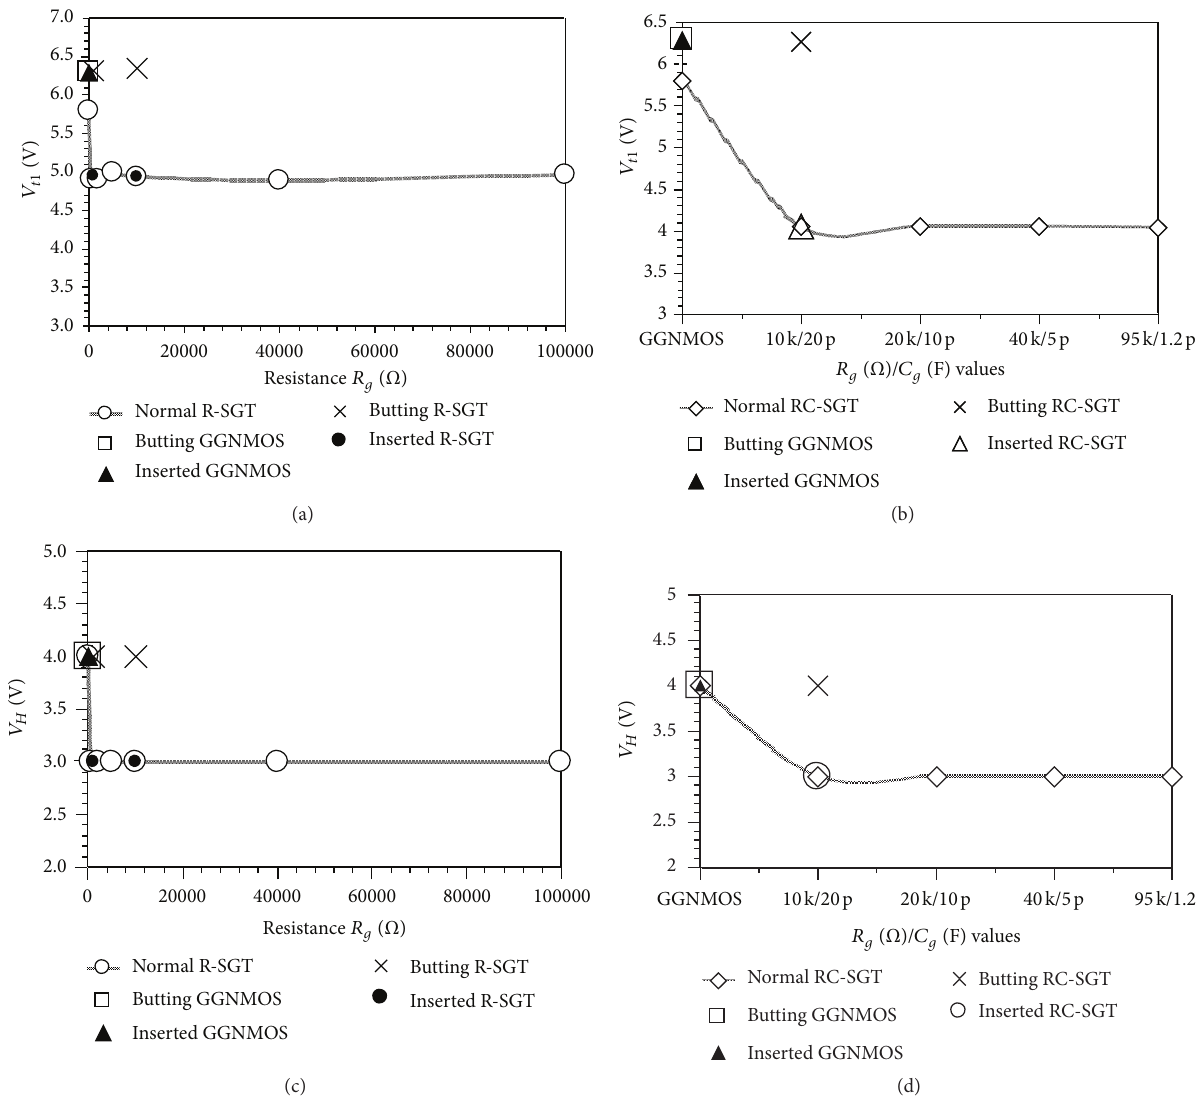
Figure 5: (a) 𝑉 𝑡1 versus resistance characteristics among the GGNMOS and resistance SGTNMOS. (b) 𝑉 𝑡1 versus 𝑅 𝑔 𝐶 𝑔 characteristics among the GGNMOS and RC-SGTNMOS. (c) 𝑉 𝐻 versus resistance characteristics among the GGNMOS and resistance SGTNMOS. (d) 𝑉 𝐻 versus resistance characteristics among the GGNMOS and RC